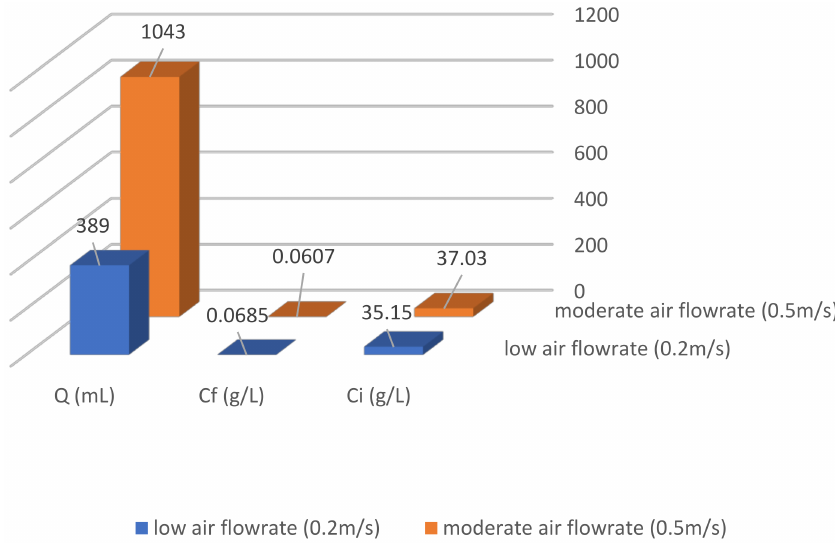
Figure 6. Effect of air flowrate after 4 h operation.